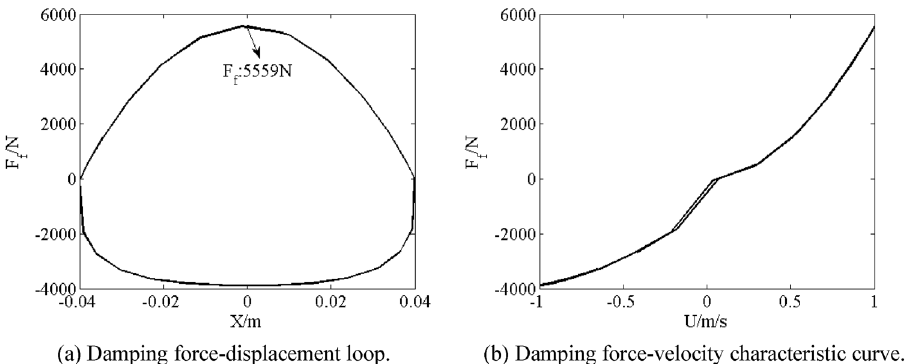
Figure 7. Simulation results of damping